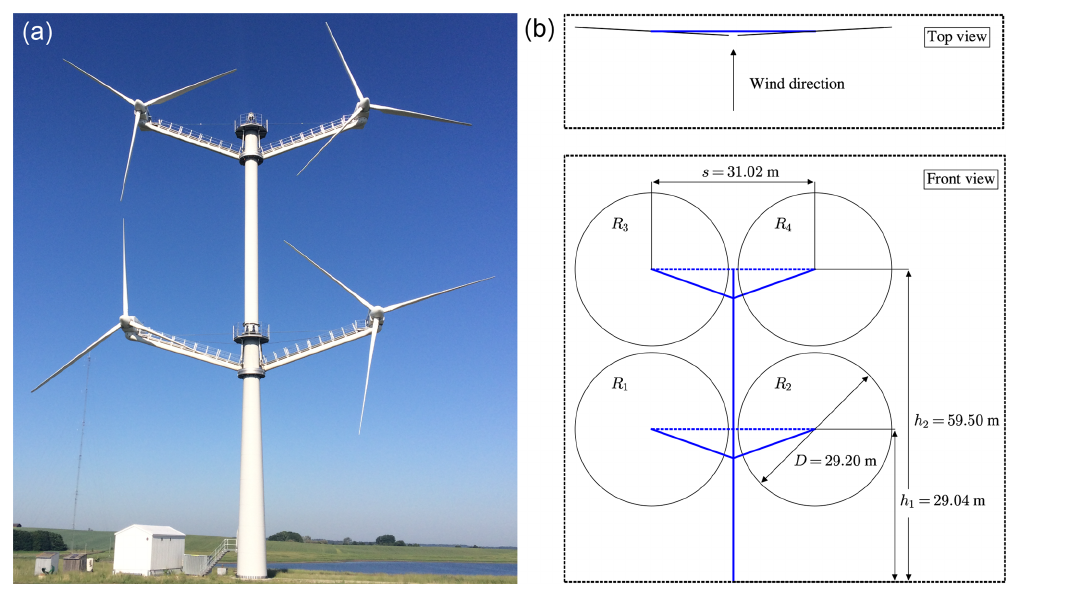
Figure 1. (a) The 4R-V29 wind turbine located at the Risø Campus. (b) Sketch of the 4R-V29 wind turbine, including dimensions and rotor definitions, shown using a top and front